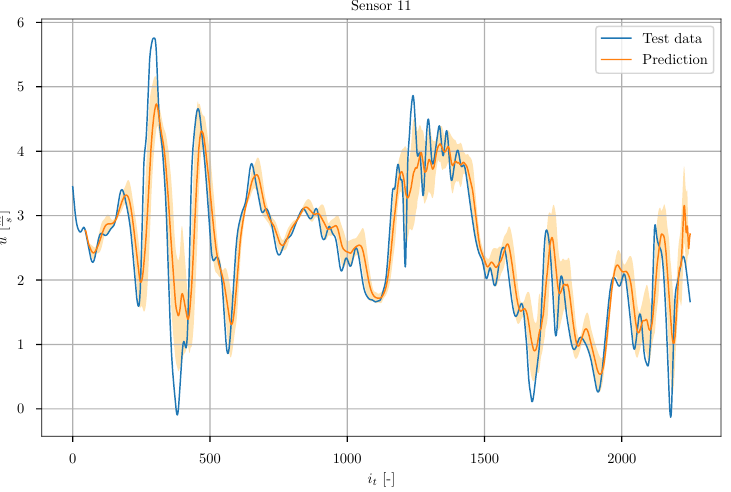
Figure 43. Averaged predicted timeseries and true timeseries of sensor 11 for adjusted n in and n out